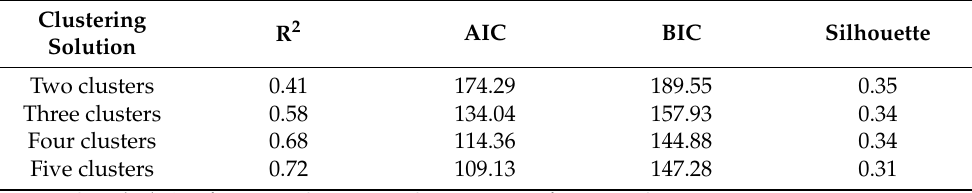
Table 2. Fit indices of solutions with two, three, four, and five